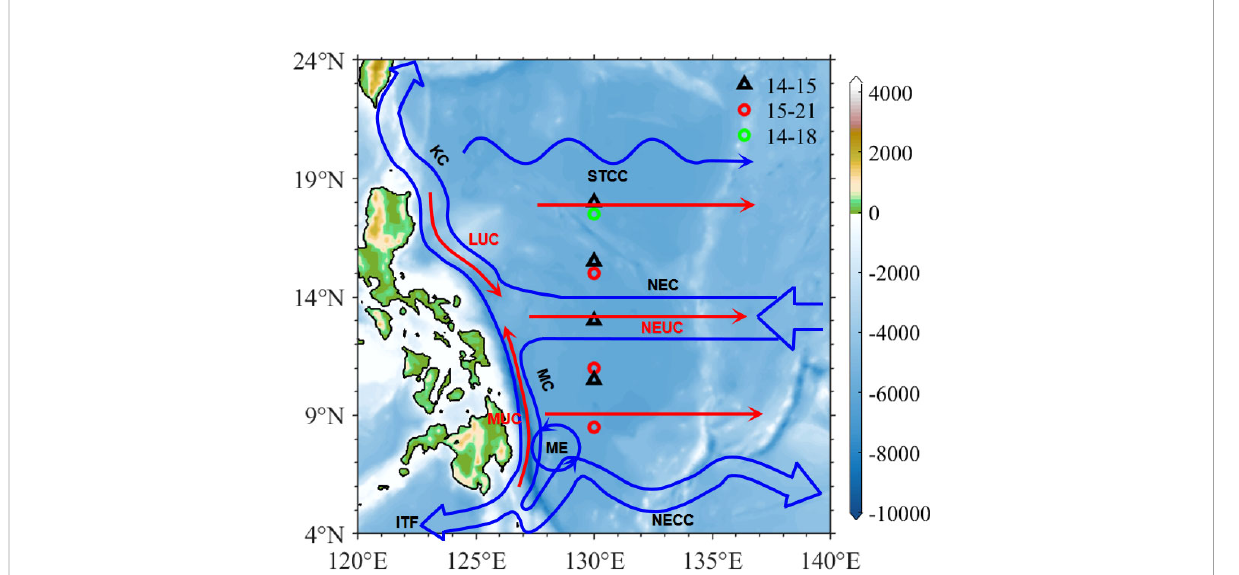
FIGURE 1 Location of the subsurface mooring array at 130°E. Black triangles denote the moorings deployed during September 2014 and September 2015 at 10.5°N, 13°N, 15.5°N and 18°N, red circles represent the moorings deployed during September 2015 and December 2021 at 8.5°N, 11°N, 12.5° N, and 15°N, and green circle represents the mooring deployed during September 2015 and January 2018 at 17.5°N. The mean ocean circulation system in this region is shown by red and blue arrows. NEC, NECC, STCC, KC, MC, NEUC, LUC, MUC, ME, and ITF stand for North Equatorial Current, North Equatorial Countercurrent, Subtropical Countercurrent, Kuroshio Current, Mindanao Current, North Equatorial Undercurrent, Luzon Undercurrent, Mindanao Undercurrent, Mindanao Eddy, and Indonesian Through fl ow,